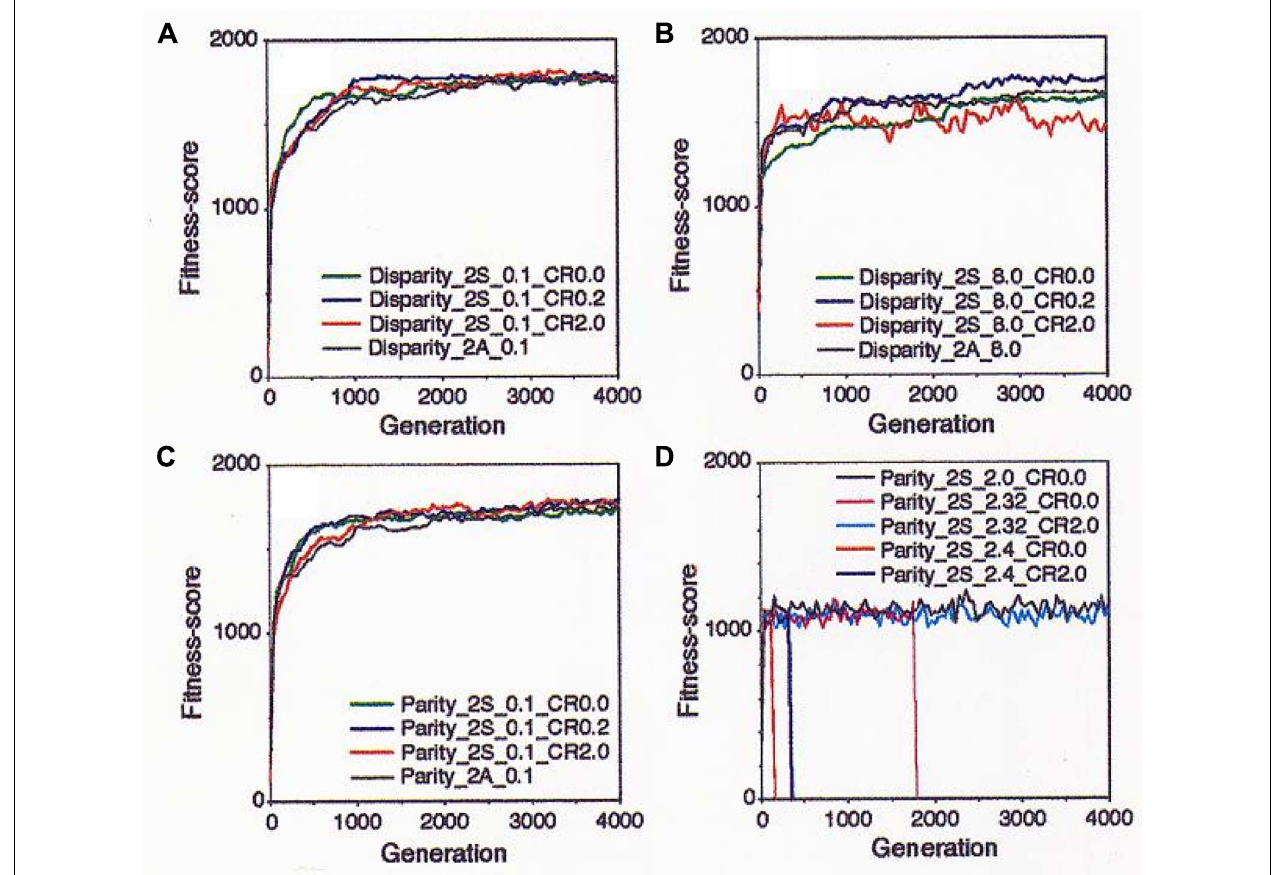
crossover; blue, CF = 0.2; red, CF = 2.0; and black, asexual. (D) Parity individual with various mutation rates. Black, n = 2.0 without crossover; magenta, n = 2.32 without crossover; cyan, n = 2.32 and CF = 2.0; red, n = 2.4 without crossover; and blue, n = 2.4 and CF = 2.0. Adapted fromWada etal. (1993); Copyright 1993, National Academy of Sciences,